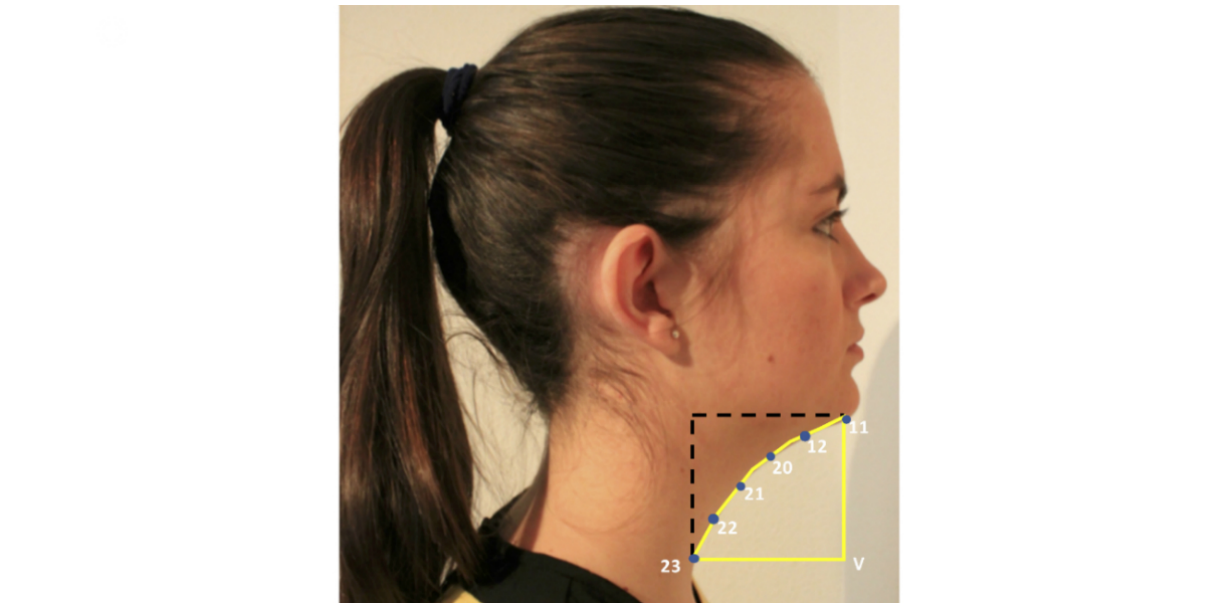
Figure 3. Measurements used for the cervicomental contour